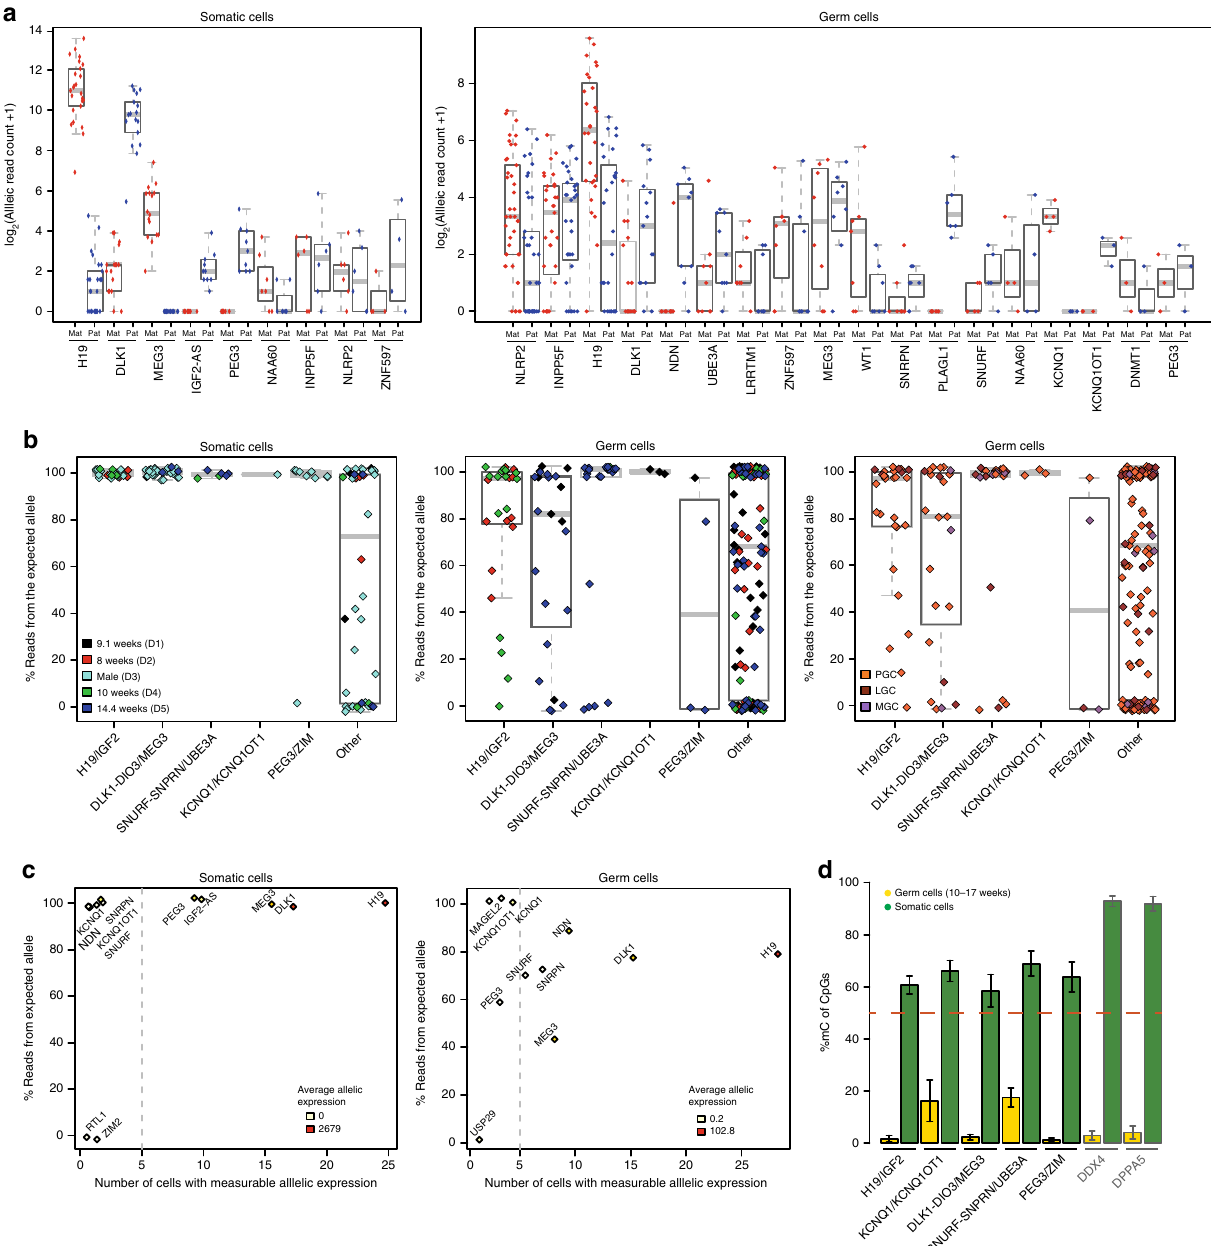
Fig. 3 Parent-of-origin allele-speci fi c expression of imprinted genes in human germ cells suggest cluster speci fi c order of imprint erasure. a Expression of individual SNP-containing imprinted genes was separated in maternal and paternal read counts in somatic and germ cells. Gray bars depict the median. b Allele-speci fi c expression of SNP-containing imprinted genes separated by imprinted gene-clusters in somatic cells (left panel) and germ cells (middle panel: colored by donor/age; and right panel: colored by developmental stage). Reported imprinted genes outside the fi ve clusters altogether showed limited imprinting in soma and germline. Allelic read count ratios were plotted in relation to the expected (by imprinting) parental allele. Gray bars depict the median. c Average allelic bias (read count ratio) of genes from the 5 imprinted gene-clusters vs. the number of somatic (left) and germ cells (right) where allelic reads were available. The number of allelic read counts are denoted as the color of each dot (gene) from white to red. Gray line: monoallelic expression in 5 or more cells is signi fi cant for a speci fi c gene being monoallelically expressed under the model of random allelic drop-out. d Quanti fi cation of DNA methylation in the analyzed and additional imprinting control regions in germ cells and somatic cells. The datasets used (germ cells and somatic cells) were from Guo et al., 2015. As control, the promoter region of DDX4 and DPPA5 shown to be methylated in somatic cells and demethylated in germ cells is also depicted. Extended analysis con fi rmed the variation in methylation patterns (Supplementary Figs. 3f, 4). Error bars denote the standard error of the